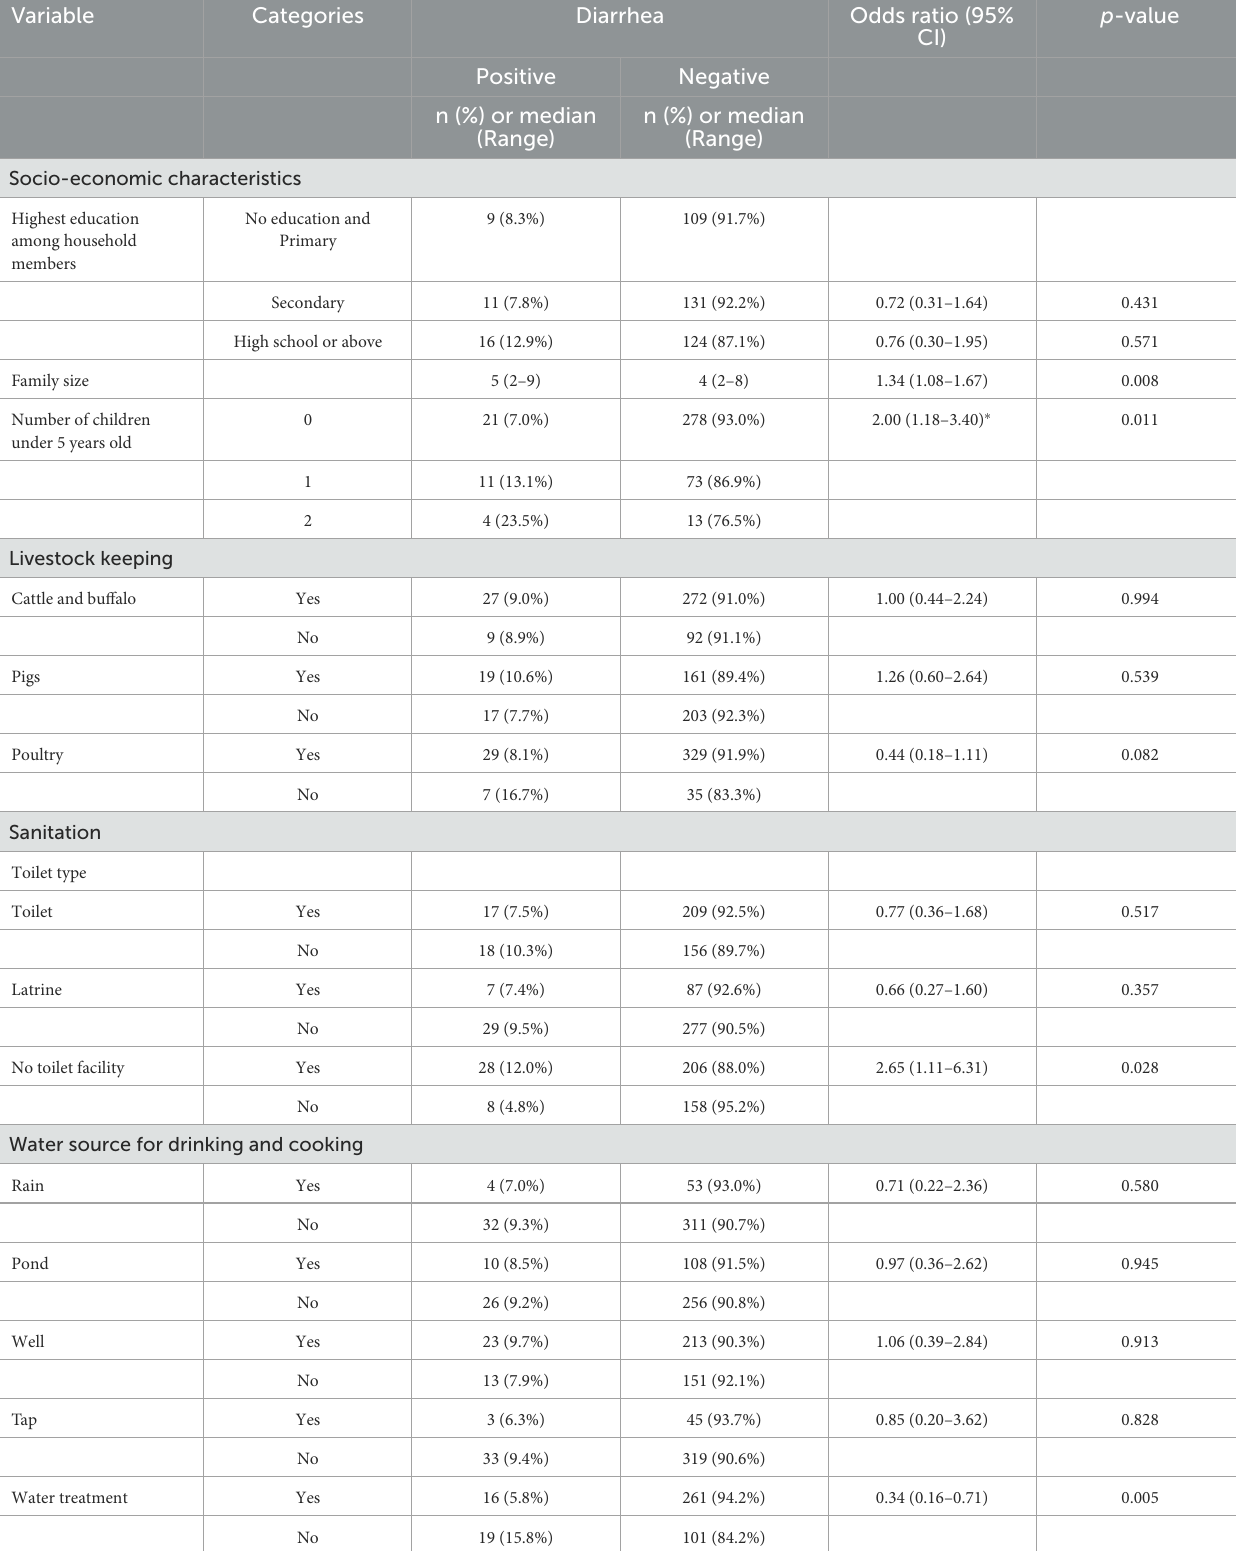
TABLE 3 Univariable risk factor analysis for diarrhea using